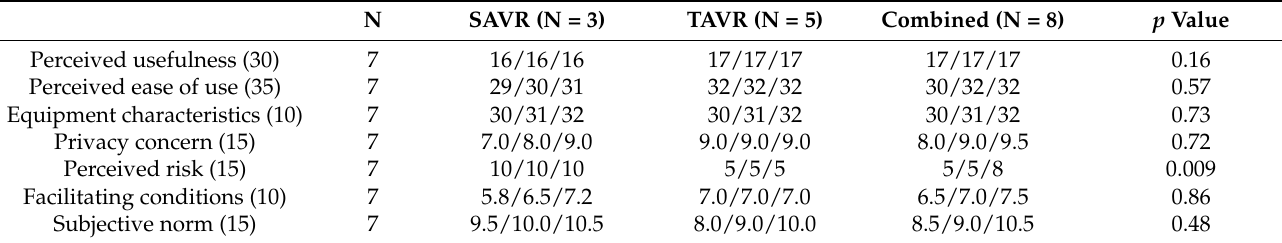
Table 4. Differences in the technology acceptance questionnaire scores per dimension according to the procedure for the overall sample. For each dimension is reported the maximum score. Data are reported as I, II and III quartiles. In parenthesis is reported the highest score for each